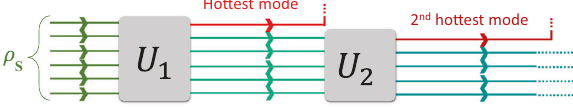
Fig. 2 Principal mode temperatures. These are de fi ned as the most extremely effective temperatures in which individual modes can be sequentially isolated using global passive linear operations (labeled by U l in the